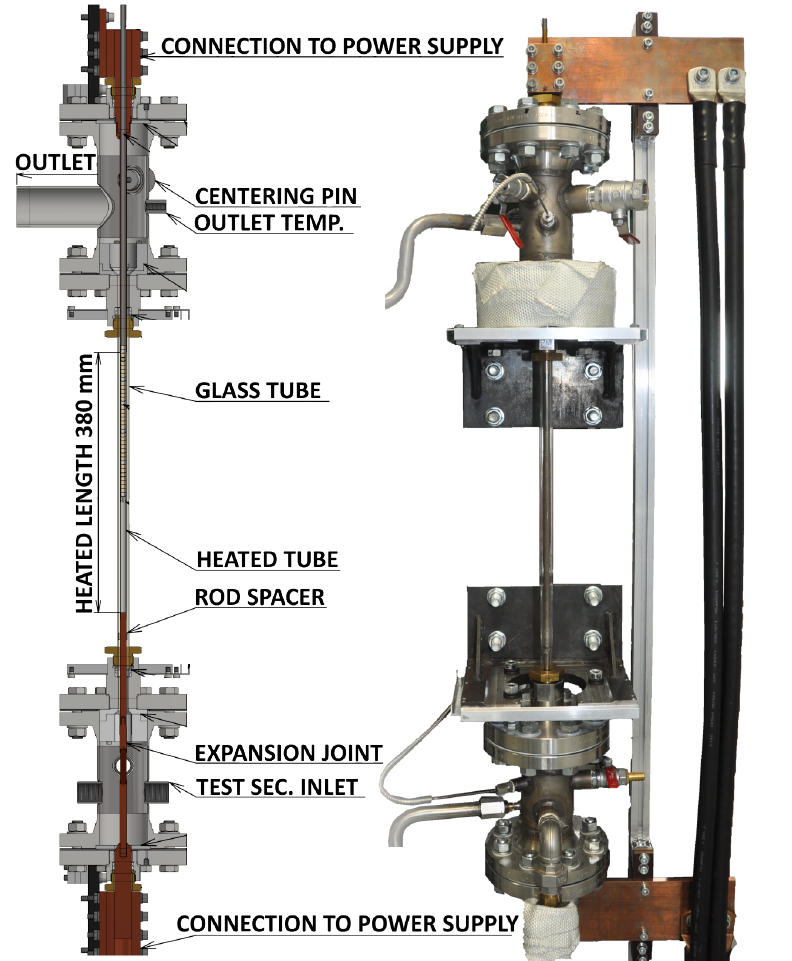
Figure 2. The cross-sectional view of the MRCHA test section and its actual